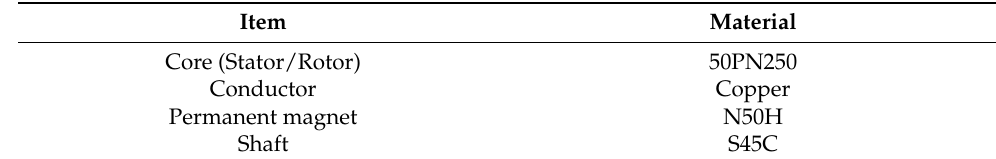
Table 2. Material list for the five-phase PMSM.